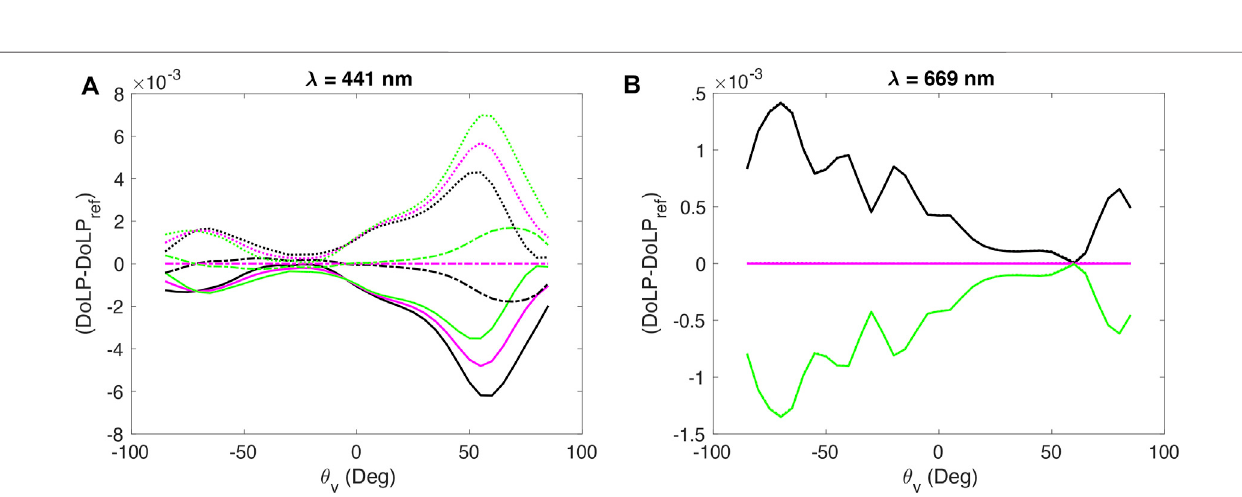
Frontiers in Remote Sensing |